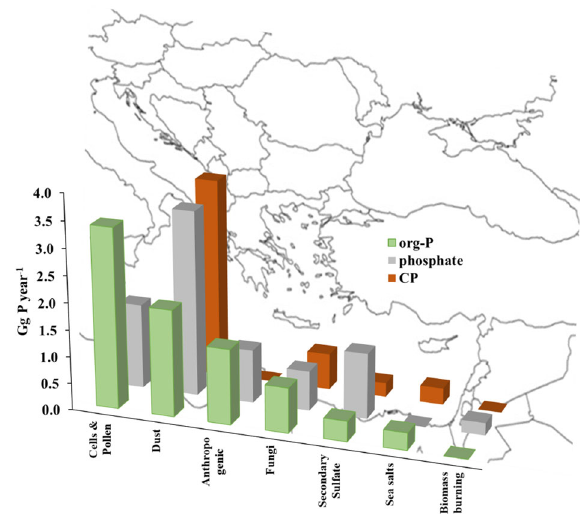
Fig. 3 Annual deposition fl uxes of P species. Estimation of the annual deposition fl uxes (in Gg P year − 1 ) of phosphorus species and their distribution to different sources over the eastern Mediterra- nean during one-year period (2016 – 2017) for total suspended particles. Total P was calculated to be 21.5 Gg P year − 1